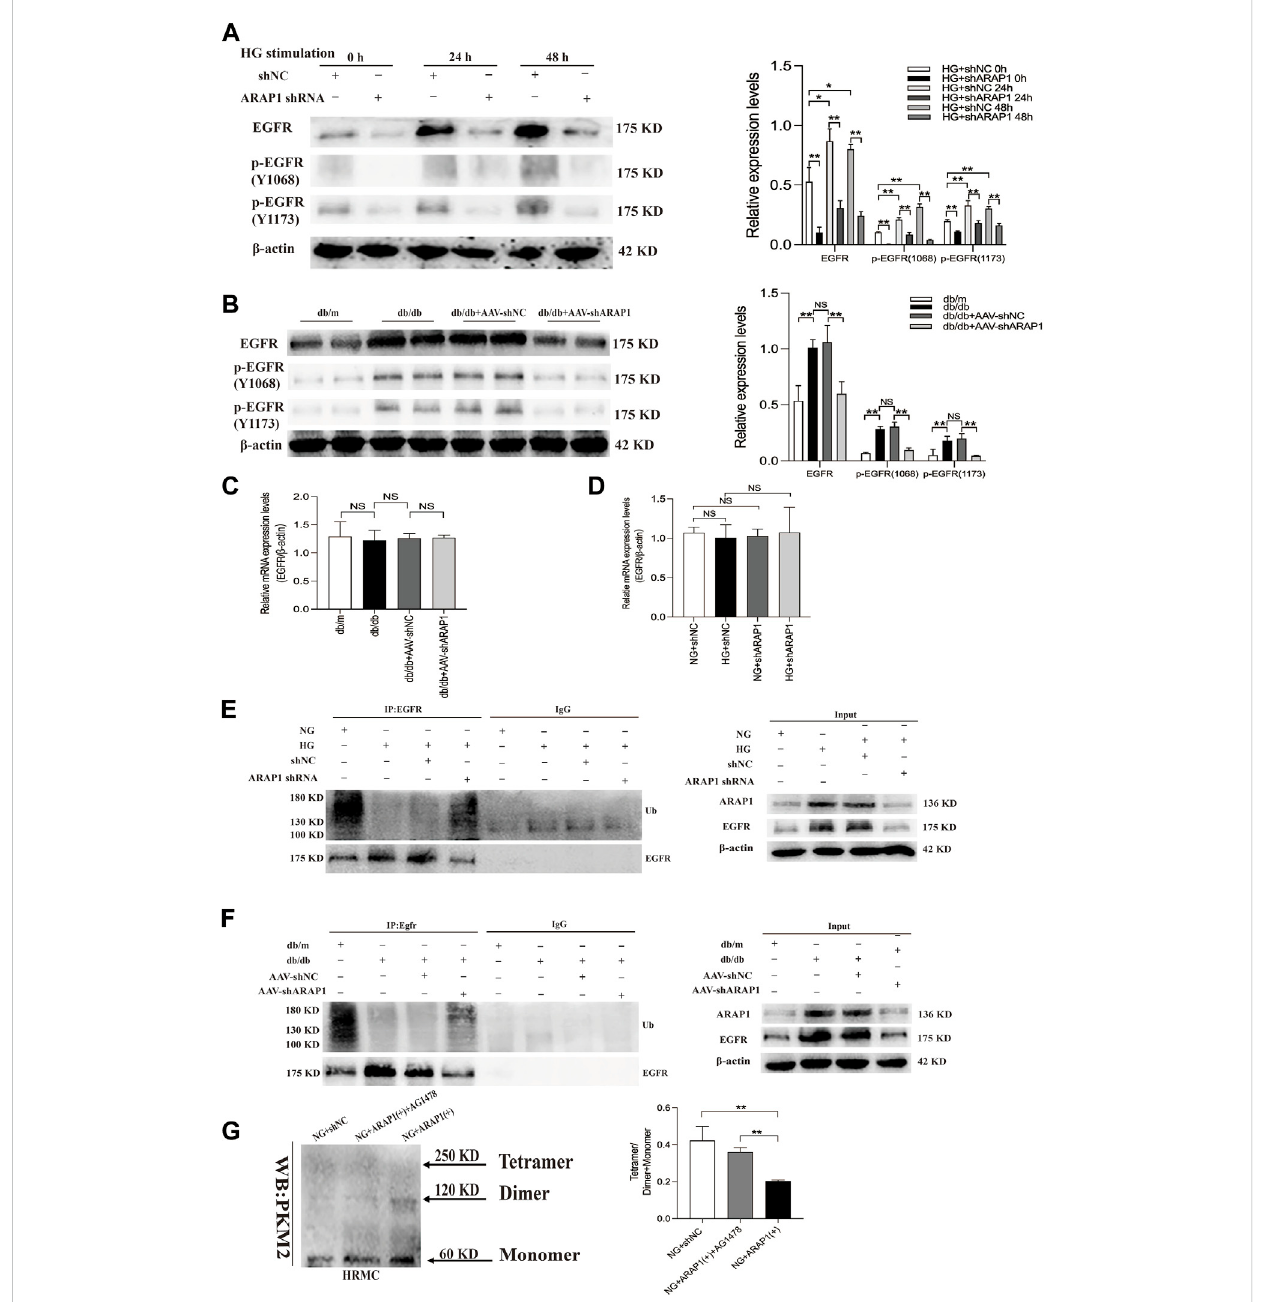
FIGURE 6 ARAP1 regulates dimeric and tetrameric PKM2 expression by reducing EGFR ubiquitination and maintaining persistent EGFR activation (A) Human glomerularmesangial cellswerepre-treatedwithARAP1shRNAfor24 handthendividedintotheNGgroupandHGgroup.Theproteinexpressionlevels of total EGFR and EGFR phosphorylated at two phosphorylation sites (Y1068 and Y1173) were detected at 24 and 48 h after stimulation by high glucose. HRMCs were pre-treated with ARAP1 shRNA for 24 h and then divided into NG and HG groups. 0 h means that the HRMCs were only transfected with ARAP1 shRNA for 24 h undernormal glucose and werenot stimulated with highglucose. (B) Effect of AAV2/9-shARAP1 on theproteinexpressionof total EGFR, and EGFR phosphorylated at two phosphorylation sites (Y1068 and Y1173) in the isolated glomeruli lysates of mouse kidney tissues was examinedbyWesternblotanalysis. (C) ThemRNAexpressionoftotalEGFRintheisolatedglomerulilysatesofkidneytissuesfromthedb/m,db/db,db/db + AAV-shNC and db/db + AAV-shARAP1 mice was measured by qRT-PCR. (D) Forty-eight hours after transfection of ARAP1 shRNA in the NG group and HG group, the mRNA expression of total EGFR was measured by qRT-PCR. (E) ARAP1 knockdown with ARAP1 shRNA increased EGFR ubiquitination in humanglomerularmesangialcellsculturedwithhighglucose. (F) ARAP1knockdownwithAAV2/9-shARAP1increasedEGFRubiquitinationintheisolated glomeruli lysates of diabetic db/db mouse kidney tissues. (G) After transfection of ARAP1 overexpression plasmid accompanied by AG1478 treatment in the NG group, PKM2 monomer, dimer and tetramer in human glomerular mesangial cells were detected by cross-linking assay. In all panels, the data are representative of at least three independent experiments. Data are presented as the mean ± SD. * p < 0.05, ** p < 0.01, NS, not signi fi